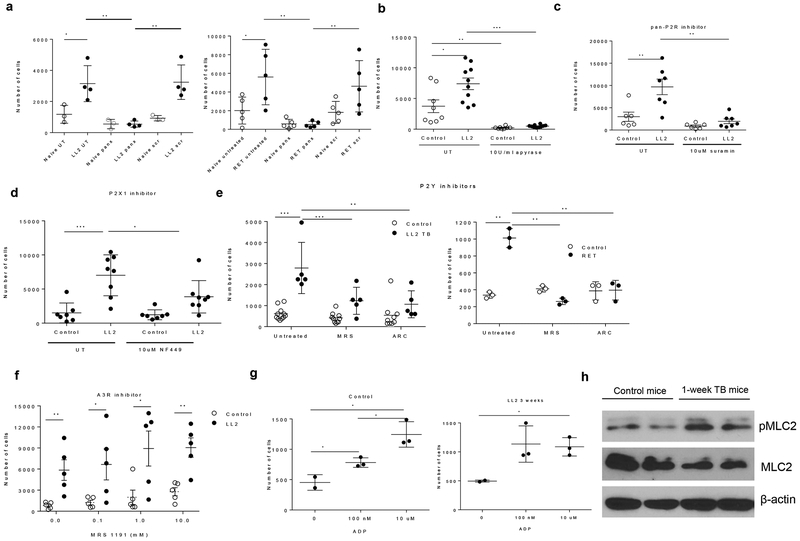
PM-LC spontaneous migration is dependent upon pannexin-1 hemichannels, extracellular ATP, and P2X and P2Y receptors.a. Transwell assays evaluating the ability of PM-LC from one-week LL2 mice (left) (n=3) and RET mice (right) (n=5) to spontaneously migrate upon pannexin-1 hemichannel inhibition (panx). b. Transwell assays evaluating the ability of neutrophils from control mice (n=8) and PM-LC from one-week LL2 mice (n=10) to spontaneously migrate upon apyrase treatment. (c-f) Transwell assays evaluating the ability of neutrophils from control mice (n=6) and PM-LC from one-week LL2 mice (n=7) to spontaneously migrate upon pan P2R inhibitor, P2XR, P2X1, P2Y, and A3R inhibition with suramin, NF449, MRS2179, AR-C118925XX, and MRS 1191, respectively. In addition, the ability of PM-LC from RET melanoma mice (n=3) to spontaneously migrate was also evaluated in the presence of P2Y inhibitors MRS2179 and AR-C118925XX. Individual values and mean and SD are shown. g. Migration of BM neutrophils from control mice (n=3) and PMN-MDSC from 3-week LL2 mice (n=3) in response to stimulation with different concentrations of ADP. Mean and SD are shown. P values are calculated in two-sided Student’s t-test. * − p <0.05; **−p<0.01; ***−p<0.001 h. pMLC2 in BM neutrophils isolated from naive mice and one-week LL2 TB mice. Experiments were performed three times with similar results.